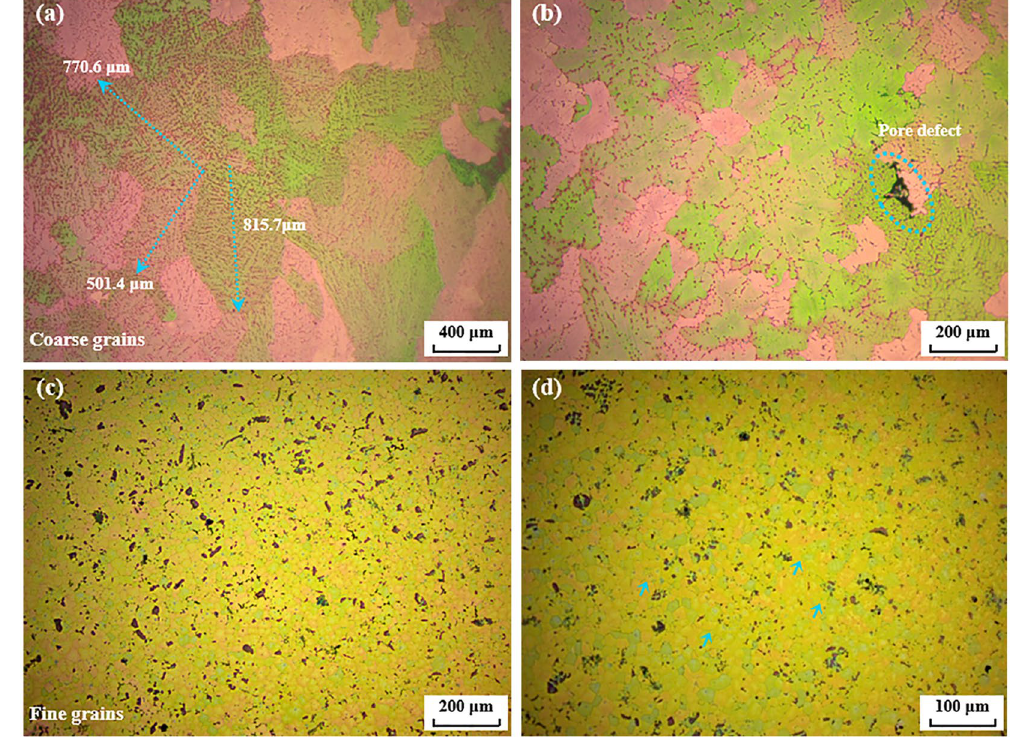
Figure 3. Typical microstructures of AA7075 (sample with cooling rate as 14.8 K/s) after T6 heat treatment. ( a , b ) Pure sample; ( c , d ) nano-treated sample.